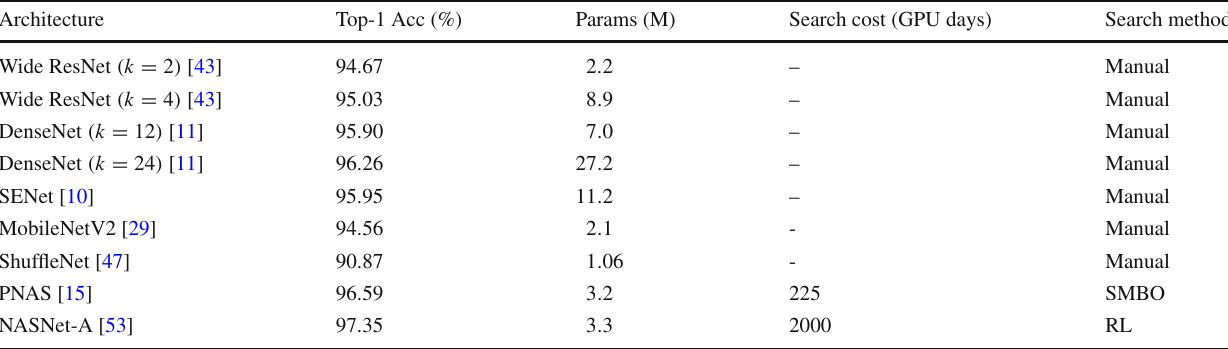
Table 2 The comparison of the proposed AEMONAS and existing peer competitors in terms of Top-1 accuracy and consumed computational cost on the CIFAR-10 datasets